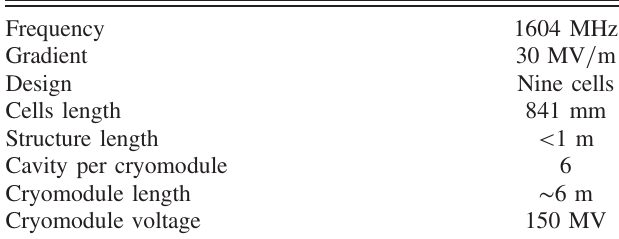
TABLE III. A tentative parameter list for the compensating rf cryomodules extrapolated from the ILC